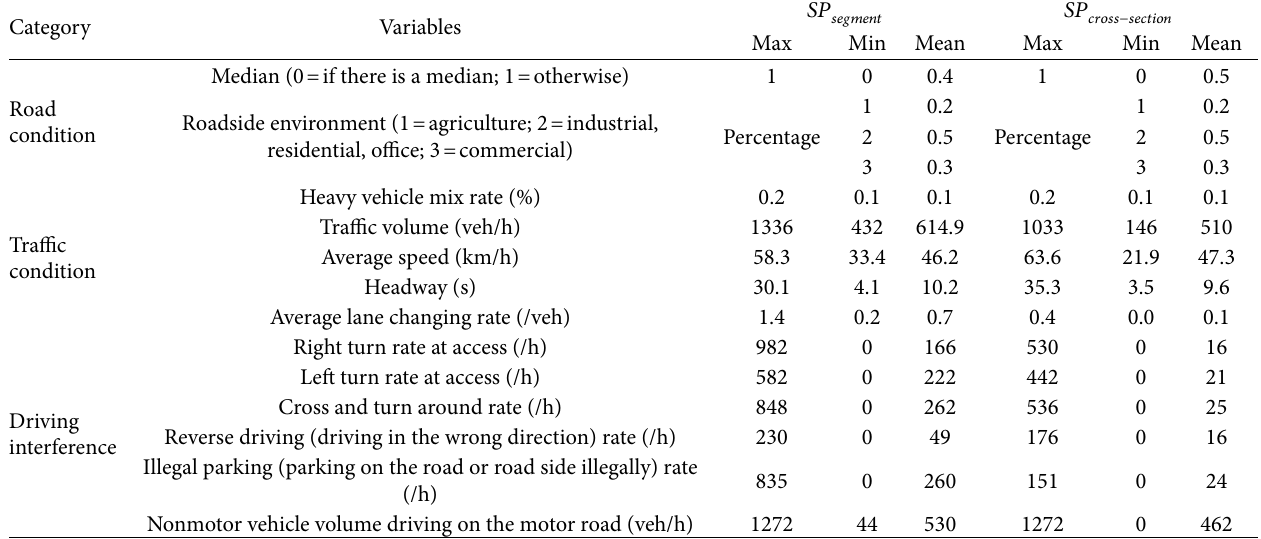
Table 3: Description of the candidate variables considered in this